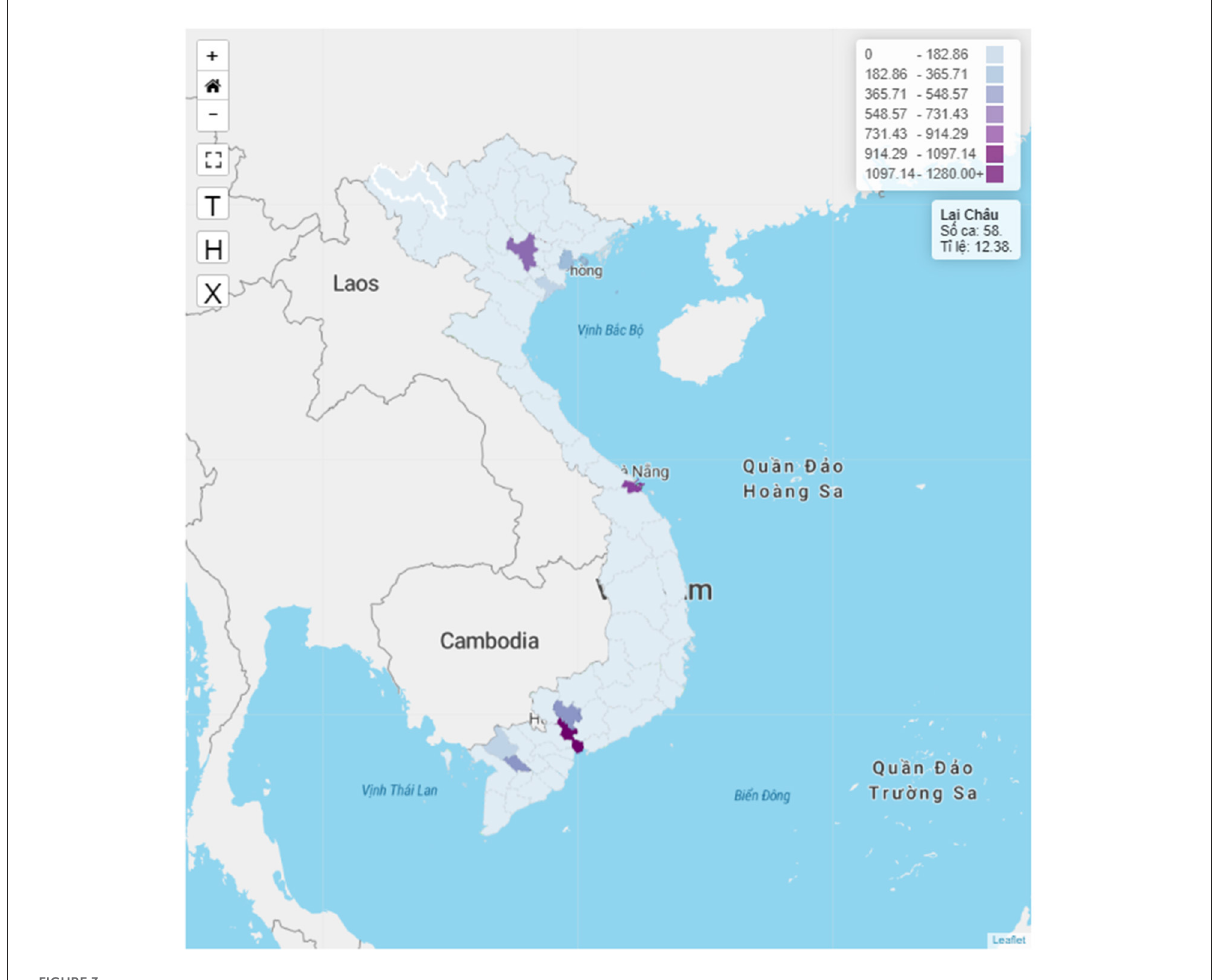
FIGURE3 Prediction of TB hotspots in